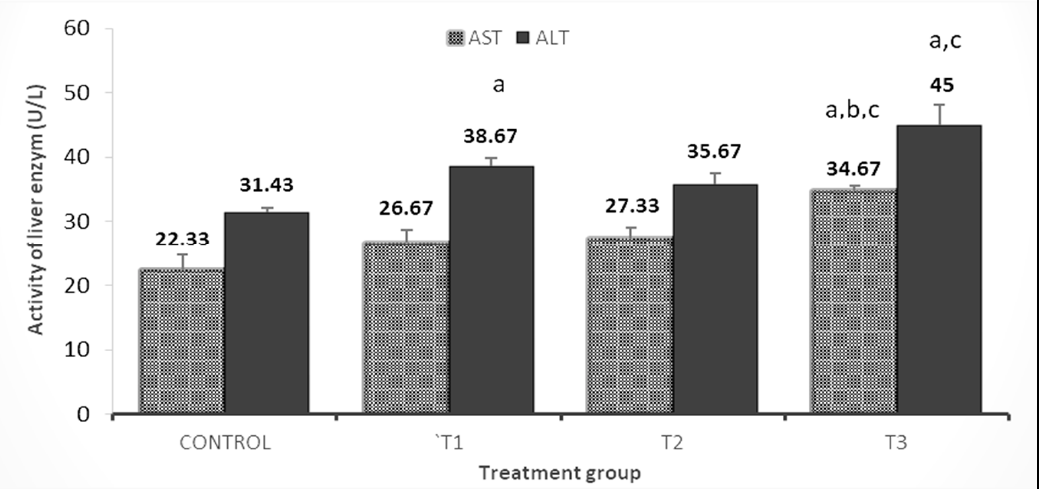
Figure 5. Effect of pomegranate peel and garlic powder separately or in combination on the activity of liver enzymes of does. Values are presented as means ± SE (n = 5 litters). T1; pomegranate peel 3%, T2; garlic 3%, and T3; pomegranate peel 1.5% + garlic 1.5%. AST; aspartate aminotransferase and ALT; alanine aminotransferase. a Significant difference as compared to control, b significant differences as compared to T1, and c significant differences as compared to T2 ( p < 0.05). The effect of the PP 3% and GP 3% treatments on urea was about 1.32-fold, and 1.46-fold respectively, as compared to the control (Figure 6). On the other hand, the results showed creatinine levels significantly decreased in the PP 3% and GP3% than in control rabbits (Figure 7).